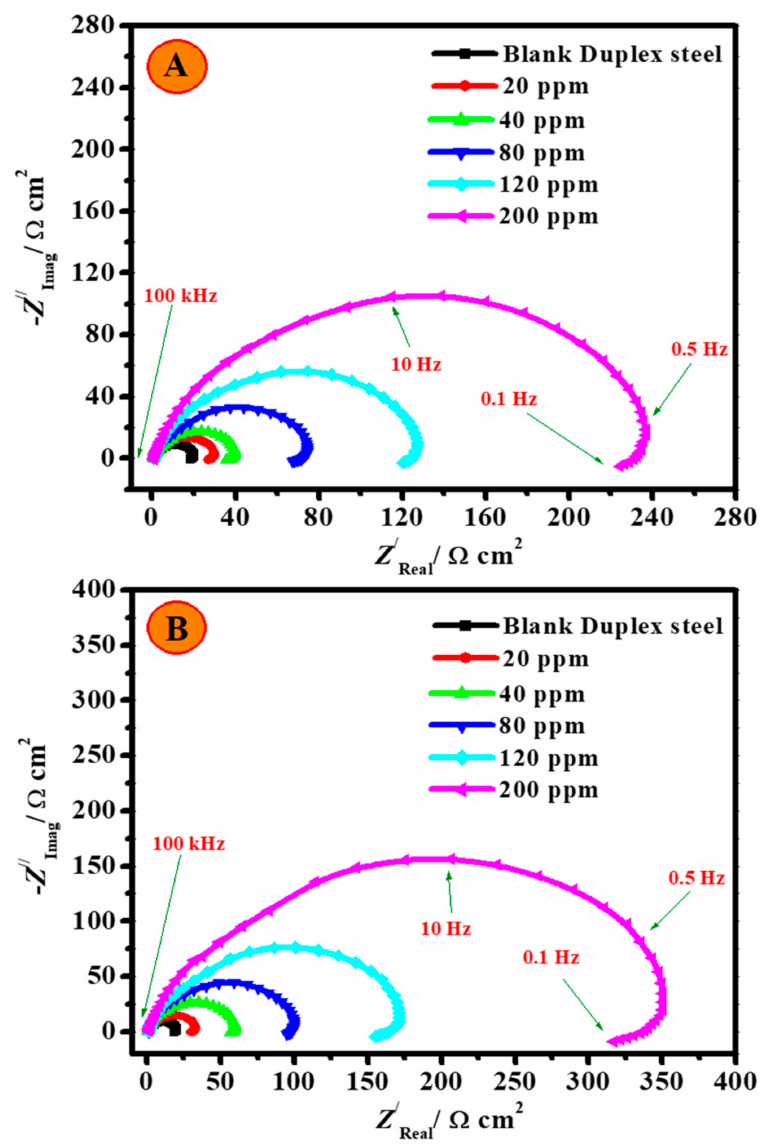
Figure 7. Nyquist plots for duplex steel at 323 K in 2.0 M H 2 SO 4 with and without various concentra- tions of ( A ) CH and ( B ) CH/Zn@H 3